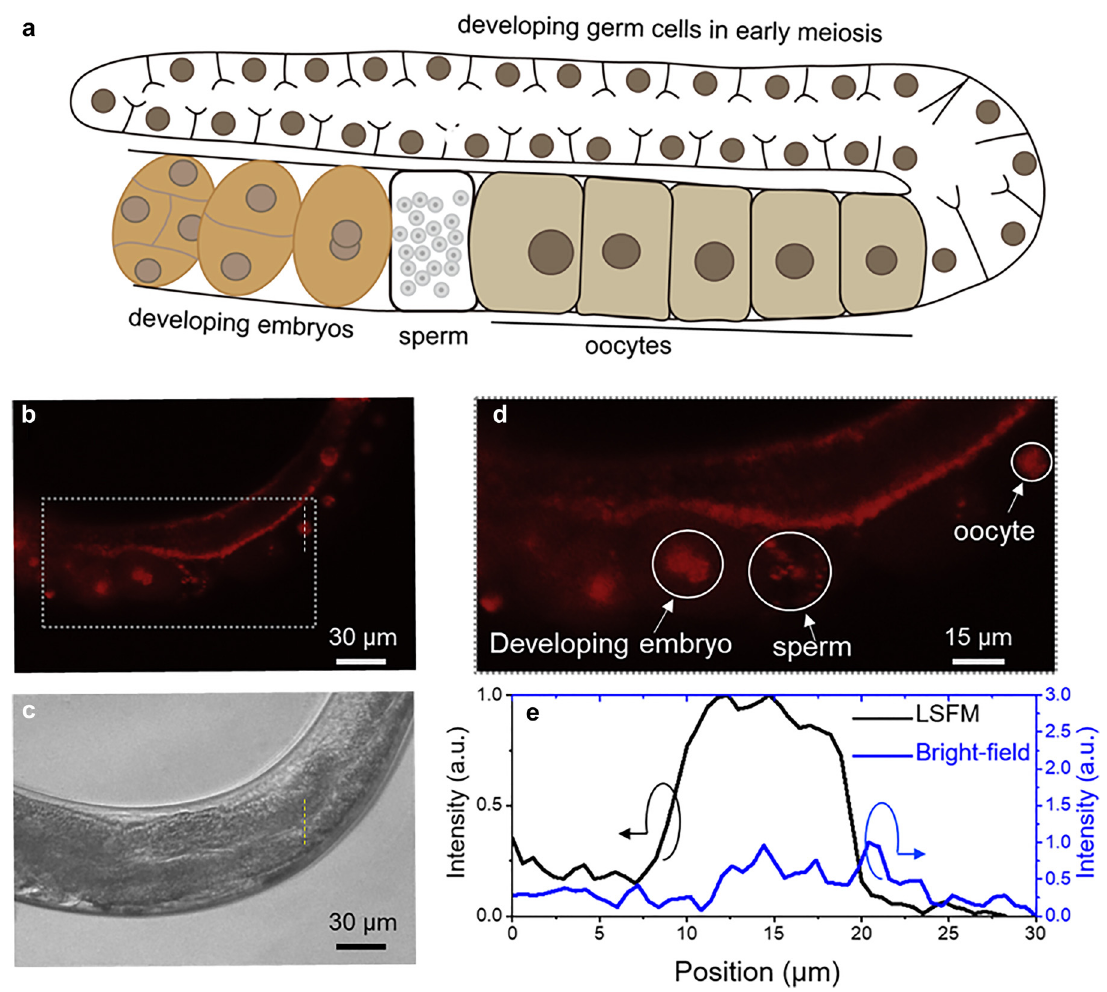
Figure 3: In vivo fl uorescence images of mCherry-tagged oocysts and embryos in a C. elegans . (a) Schematic diagram of a C. elegans . (b) LSFM image of the C. elegans immobilized in agar. (c) Bright- fi eld image of the C. elegans . (d) The correspondingzoom-inLSFMimage.(e)Intensitycross-sectionsalongthelinesplottedin(b)and(c),respectively.(b)and(c)areshownonthe same